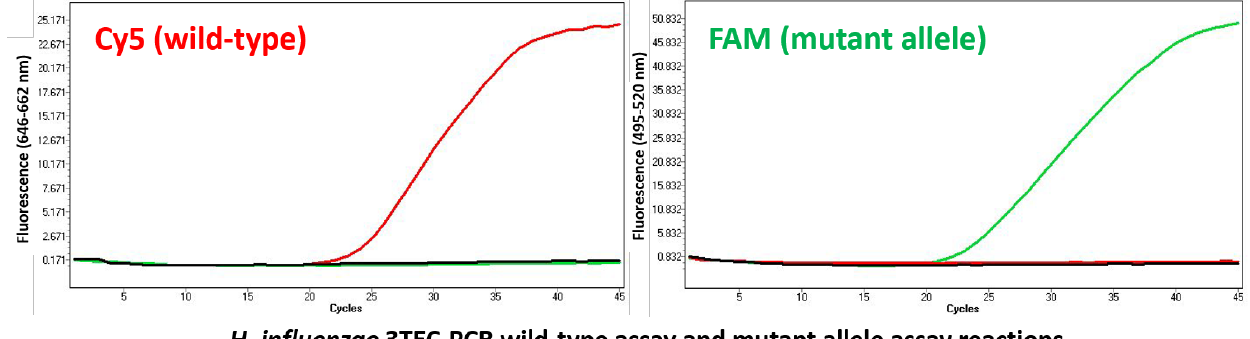
Figure 3. 3TEC-PCR allele-specific detection. The H. influenzae 3TEC-PCR wild-type assay and mutant allele assay were both tested using synthetic DNA templates, SNP0 and SNP1, at 10 4 genome copies with no template control reactions carried out in parallel. SNP0 is a sectional copy of the H. influenzae fucK gene, without SNPs, acting as a wild-type template. SNP1 is a copy of the SNP0 template, with an SNP in the H. influenzae wild-type forward primer/probe target region, acting as a mutant allele template. Resulting amplification fluorescence was recorded with the LightCycler 480 Instrument II using the Cy5 (wild-type) and FAM (mutant allele) fluorescence-detection channels. The SNP0 template (red) was only detected in the Cy5 channel and the SNP1 template (green) was only detected in the FAM channel, indicating single-base specificity and accurate allele-specific detection with both assays. The negative control reactions performed successfully as no signal generation was observed